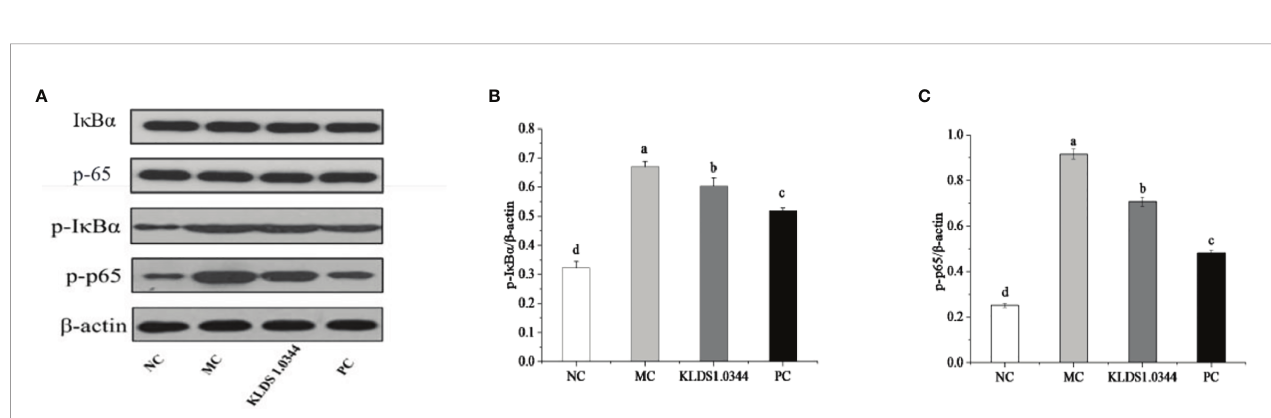
FIGURE 6 | The western blot detection map (A) of the tested strains affecting the NF- k B signaling pathway. LPS-induced expression of p-I k Ba (B) and p-p65 (C) protein in the NF- k B pathway of mouse breast tissue. NC, normal control group; MC, LPS-induced mastitis group; KLDS1.0344, KLDS1.0344 pretreatment group, PC, pretreated with dexamethasone group. Values are mean ± SD. Means with no common letters differ signi fi cantly (P <